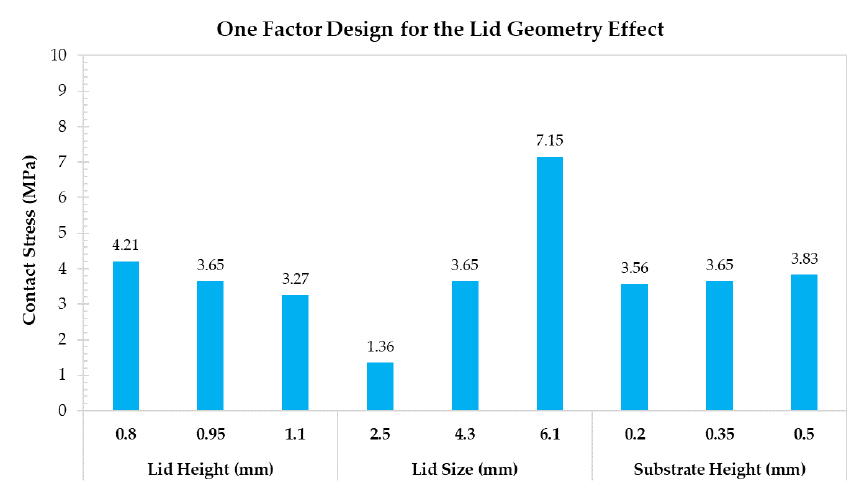
Figure 11. One factor design for discussing the contact area effect.